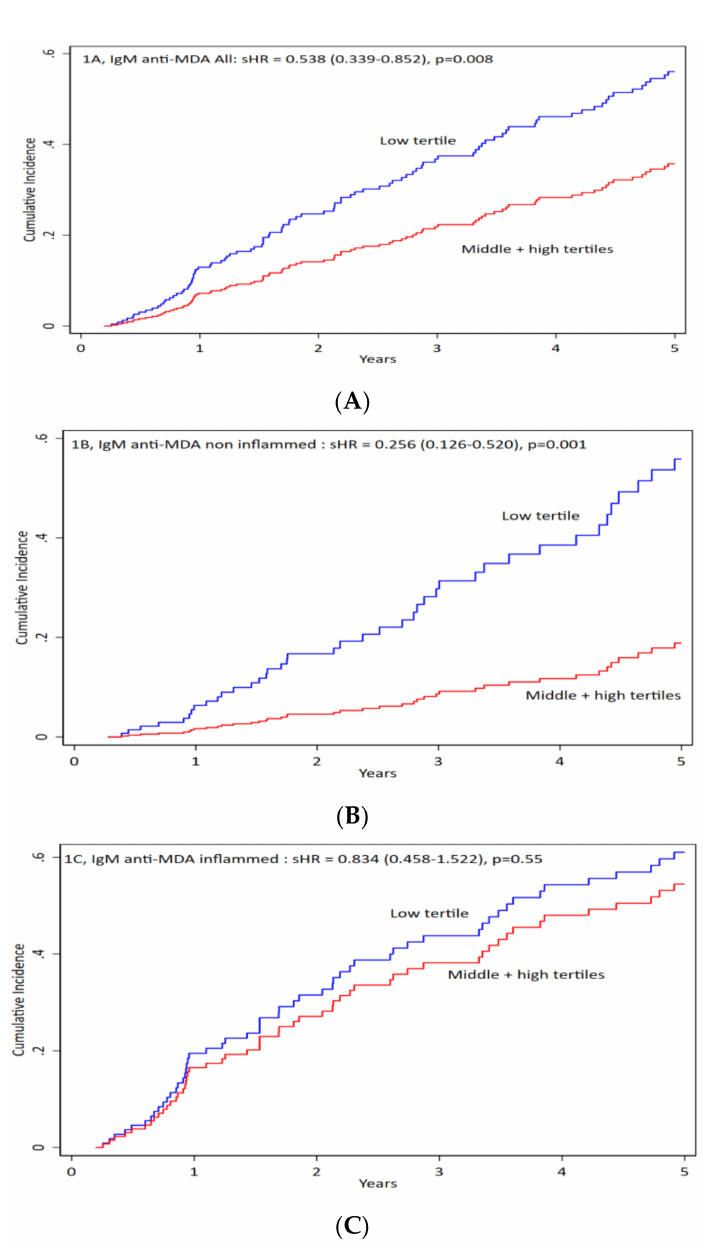
Figure 1. IgM anti-MDA impact on the mortality of all patients and inflamed versus non-inflamed. Patients were divided in three groups: ( A ) for all patients, ( B ) for non-inflamed patients, and ( C ) for inflamed patients. Antibody levels were divided into low vs. middle + high levels of IgM antibodies against malondialdehyde (anti-MDA) for cumulative incidence vs. time. For all patients the sub-hazard ratios (sHR) is 0.54 (0.34–0.85), p = 0.008. For non-inflamed patients sHR is 0.26 (0.13–0.52), p =